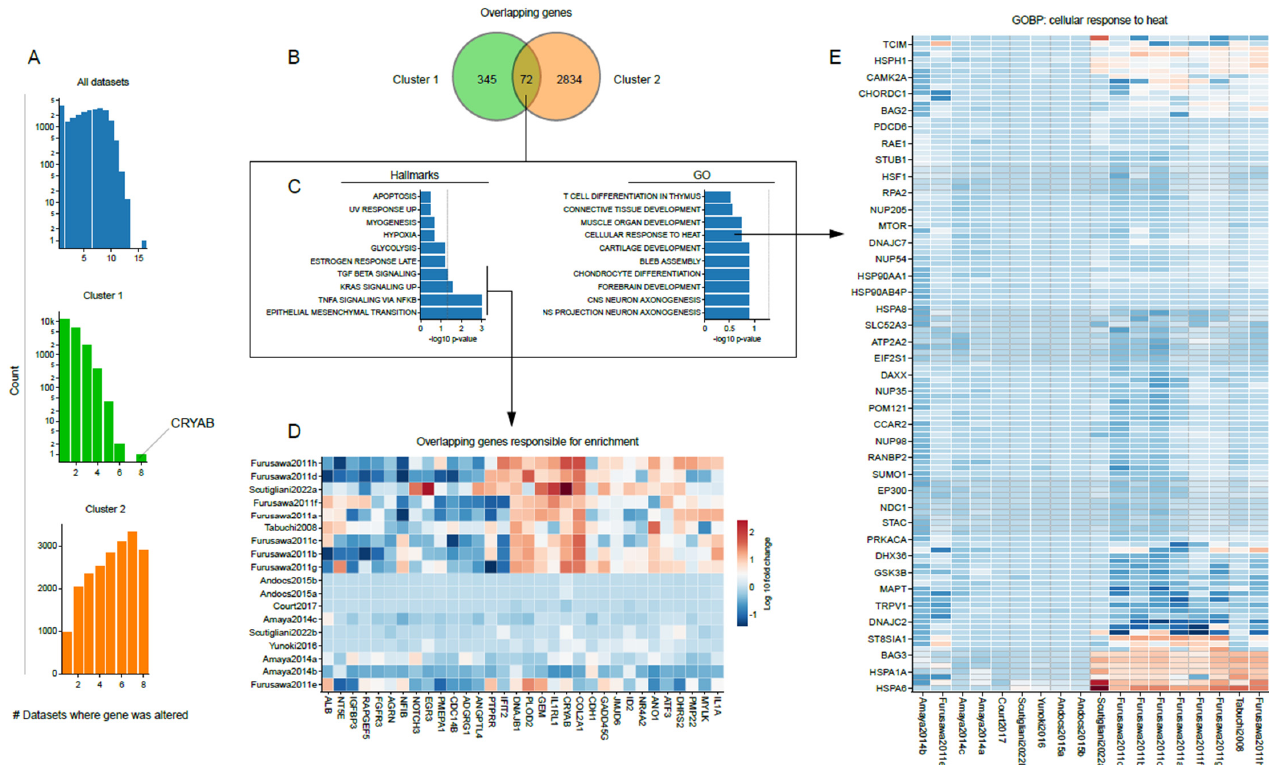
Figure 3. Different genes drive transcriptome changes. ( A ) The frequency at which genes are differentially expressed in the datasets assigned to cluster 1 and 2. ( B ) Venn diagram showing the overlap in genes that were found to be differentially expressed in at least three datasets of cluster 1 and seven datasets of cluster 2. ( C ) The result of an overrepresentation analysis (hallmark and gene ontology (GO) biological processes of gene sets) that used 72 genes shared between the clusters, as shown in ( C ), as input. ( D ) Log fold expression change of the genes that contributed to the enrichment of hallmark gene sets shown in ( C ). ( E ) Log fold expression change of genes that are assigned to the GO term “response to heat stress”. The scaling is identical as in ( D ).